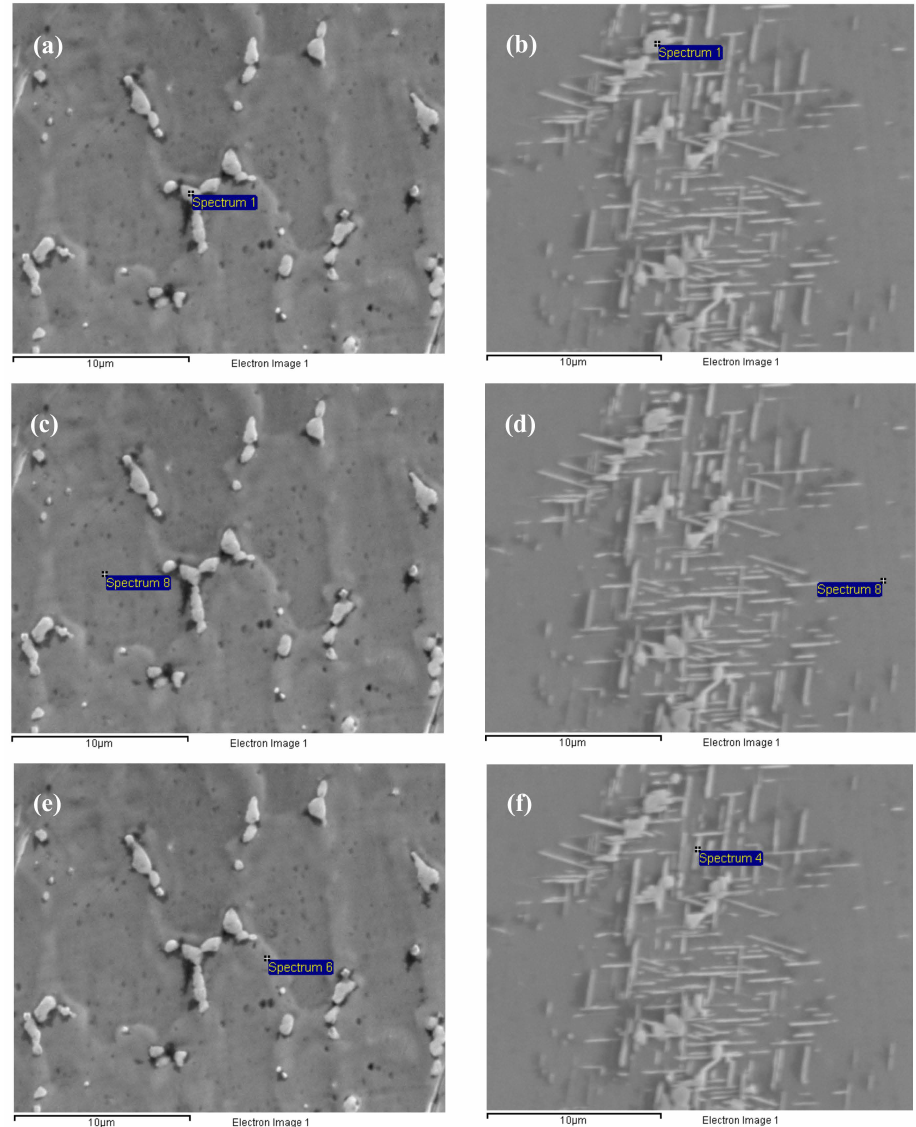
Figure 4. Energy dispersive spectrometer measurement for the Inconel 718 with the δ aging for 0 h in ( a , c , e ), and with aging for 12 h in ( b , d , f ). The locations of the measurement are in the Laves phase ( a , b ); the core dendrite ( c , d ); the γ (eutectic) area ( e , f ).